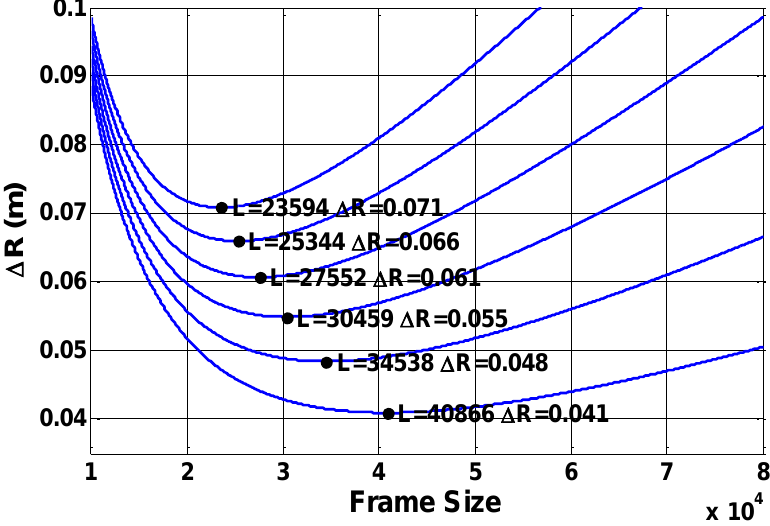
Figure 14. Minimum distinguishable range interval vs. frame